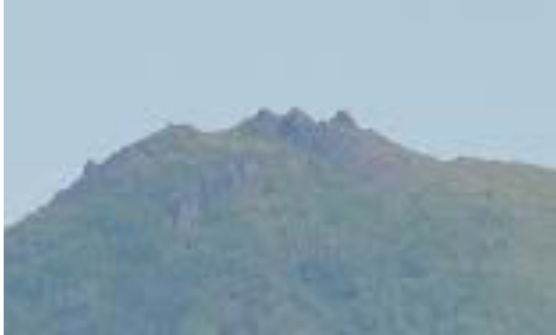
Figure 2. The top of Mt. Usu (measurement target)